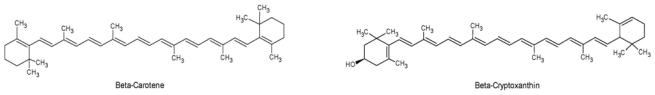
Chemical structure of the steroids isolated from G. edulis.